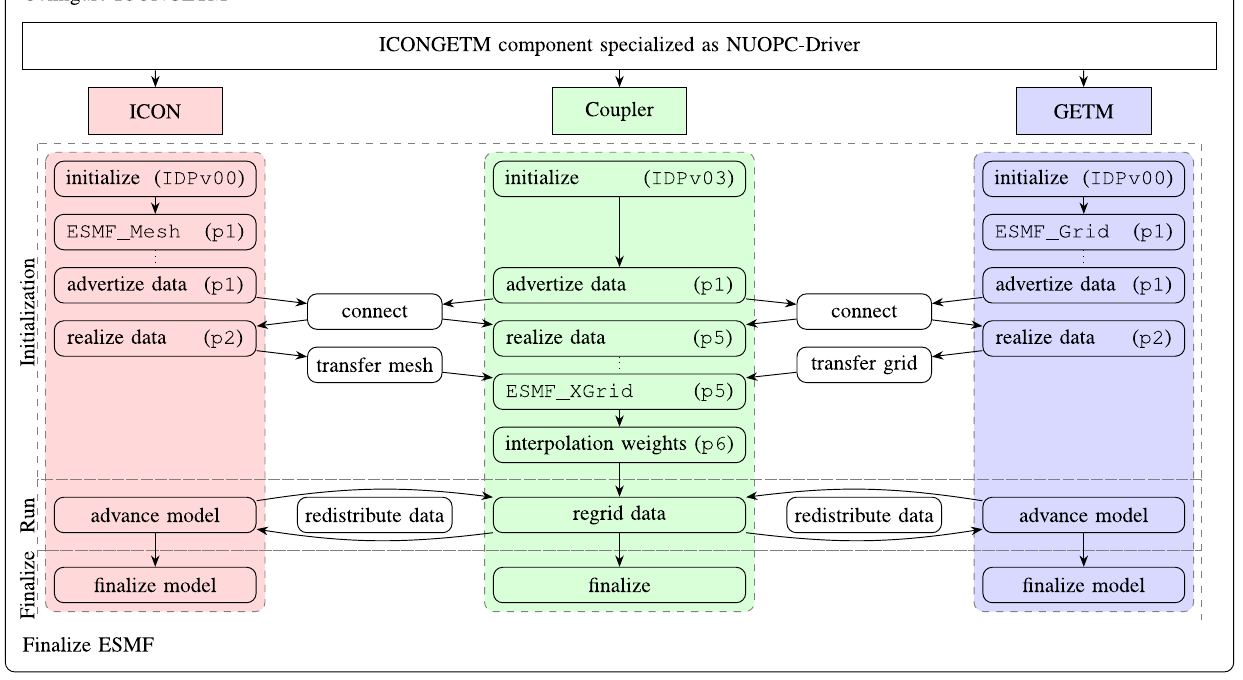
Figure 1. Structure of ICONGETM. The ICONGETM component created by the main program is specialized as NUOPC-Driver and consists of NUOPC-Model components for ICON and GETM as well as an NUOPC-Mediator for the Coupler. For all components the implemented specialized routines for initialization, run and finalization are indicated. The initialization phases of the NUOPC layer are given in paren- theses. Automated generic NUOPC operations are represented by arrows. In the pdf version of this article the central NUOPC components presented in the figure are linked to the corresponding locations in the source